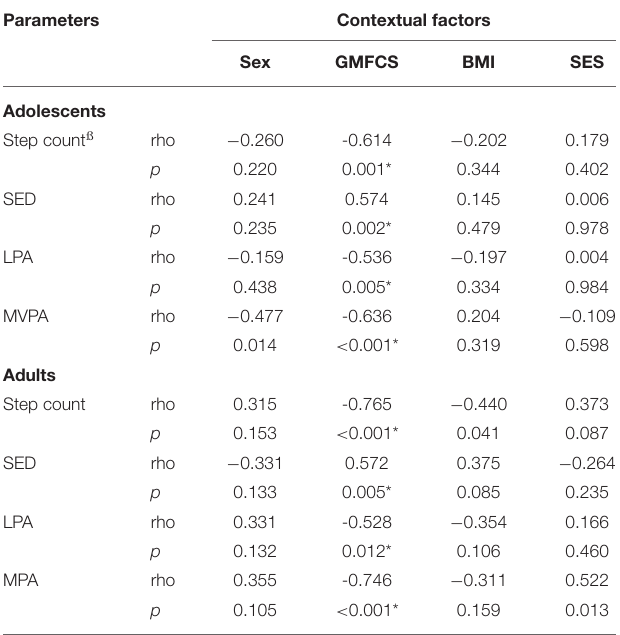
TABLE 2 | Overview of the associations between step count and level of physical activity (minutes per hour) # and contextual factors for adolescents ( n = 26) and adults ( n = 22) with cerebral